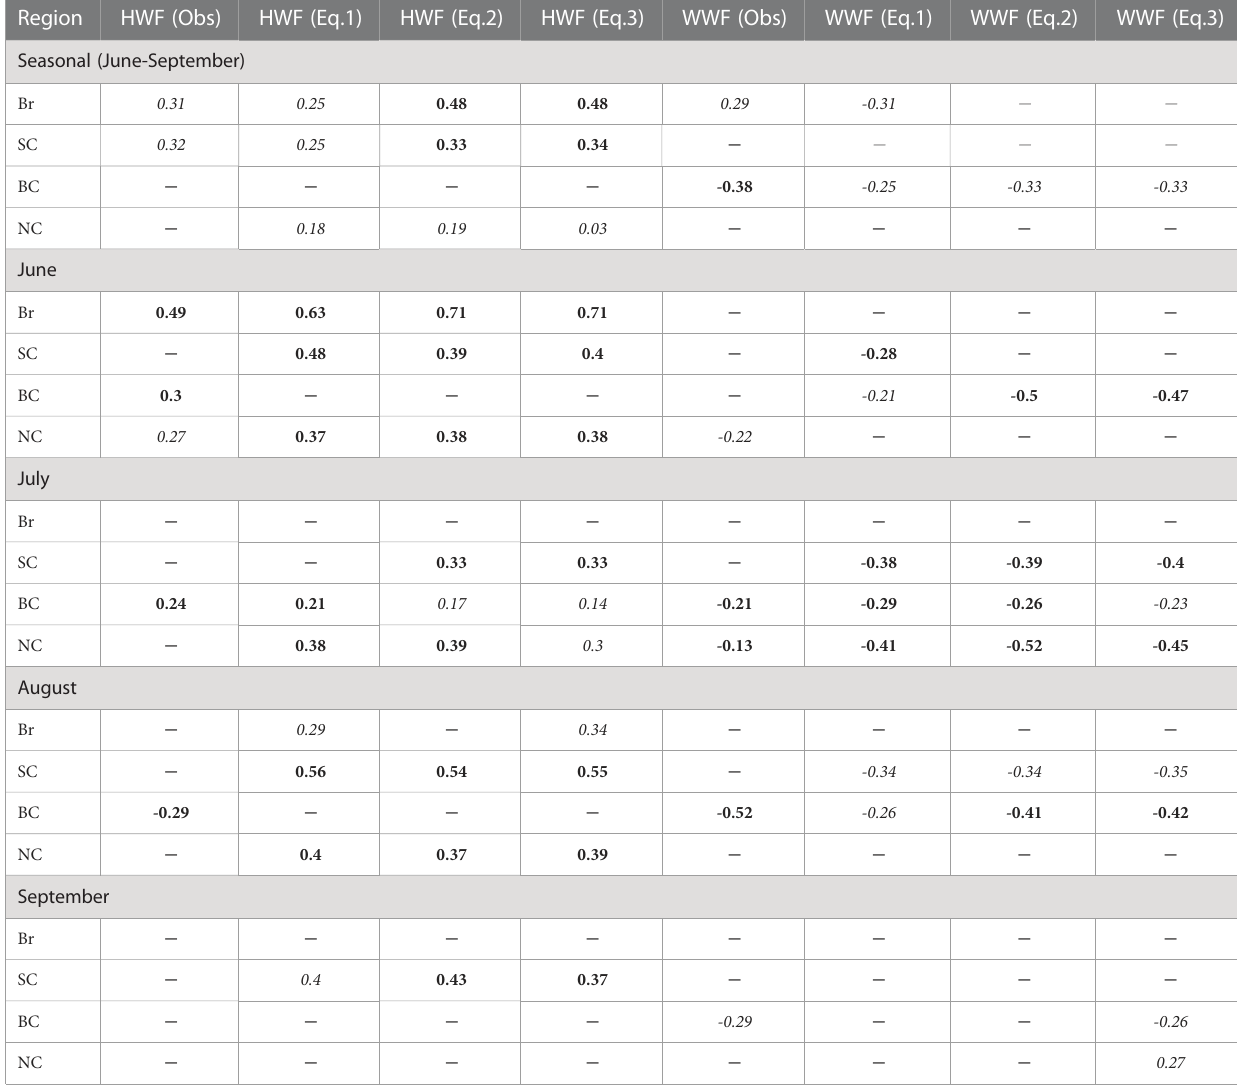
TABLE 1 Correlation coef fi cients between HWF/WWF and NPP of multiple linear regression models using Equation (1)-(3), and comparison with the observations (Crawford et al., 2020).